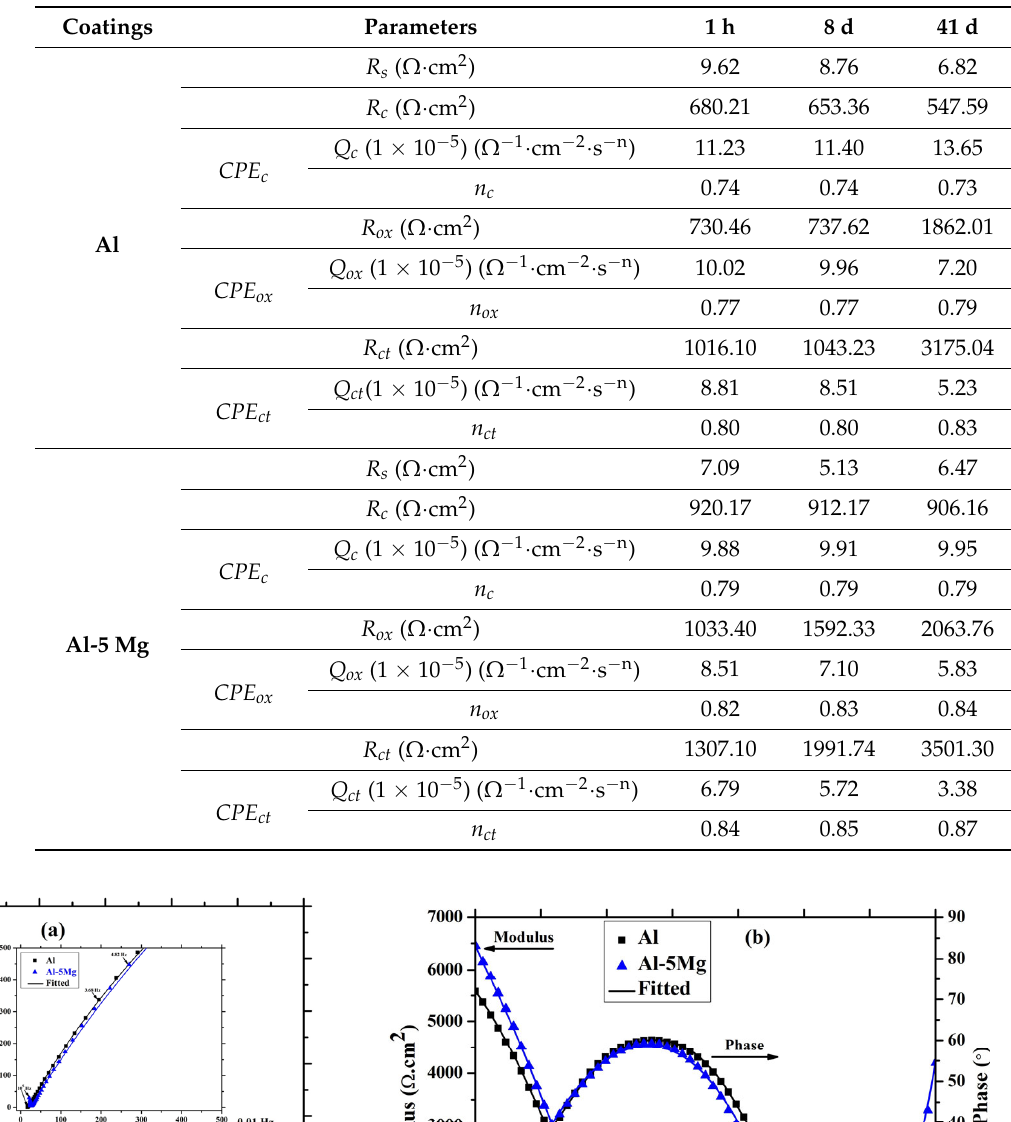
Table 2. Electrochemical parameters of the coatings.